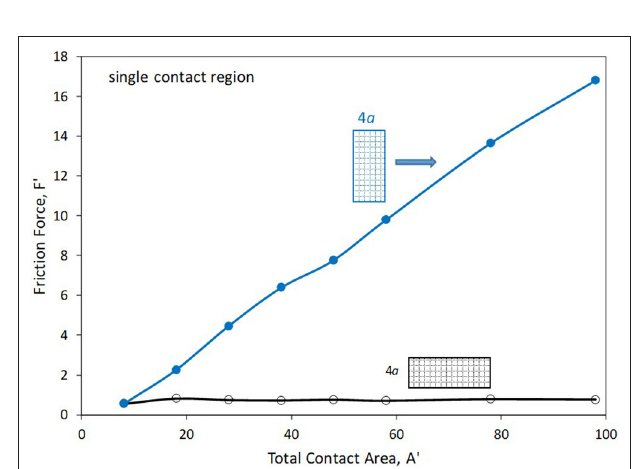
FIGURE 5 | Friction force and normal load vs. contact area for single square regions of varying size.